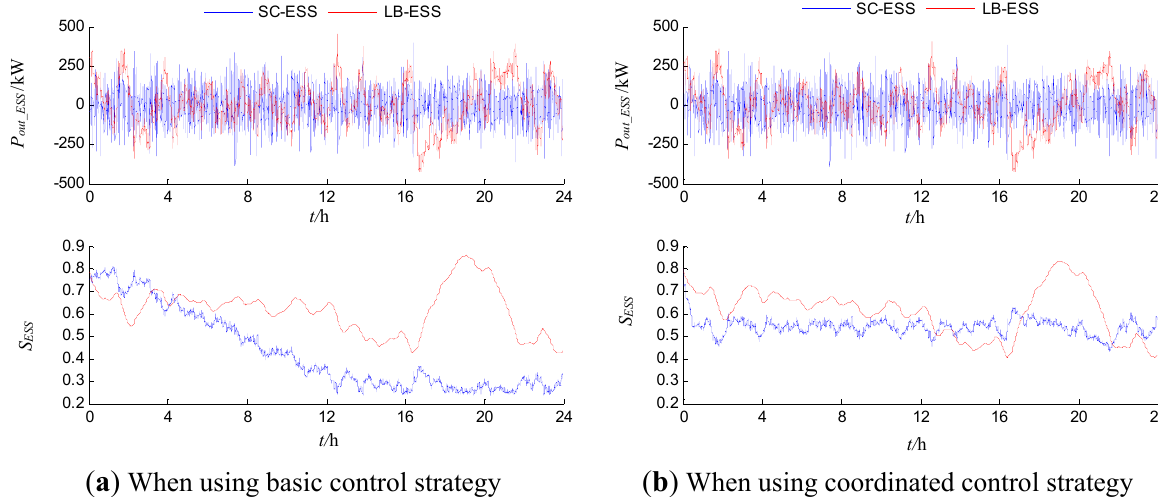
Figure 6. Output power and SOC of two ESSs using two strategies when T f =